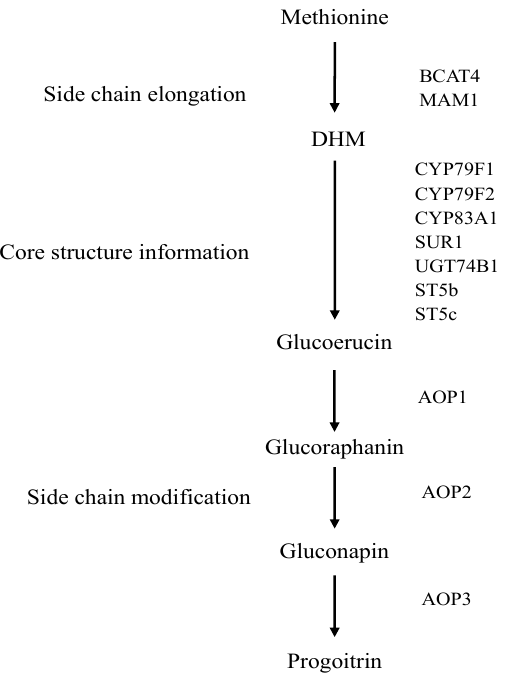
Figure 1. The biosynthetic pathway of glucoraphanin in Brassica vegetables.